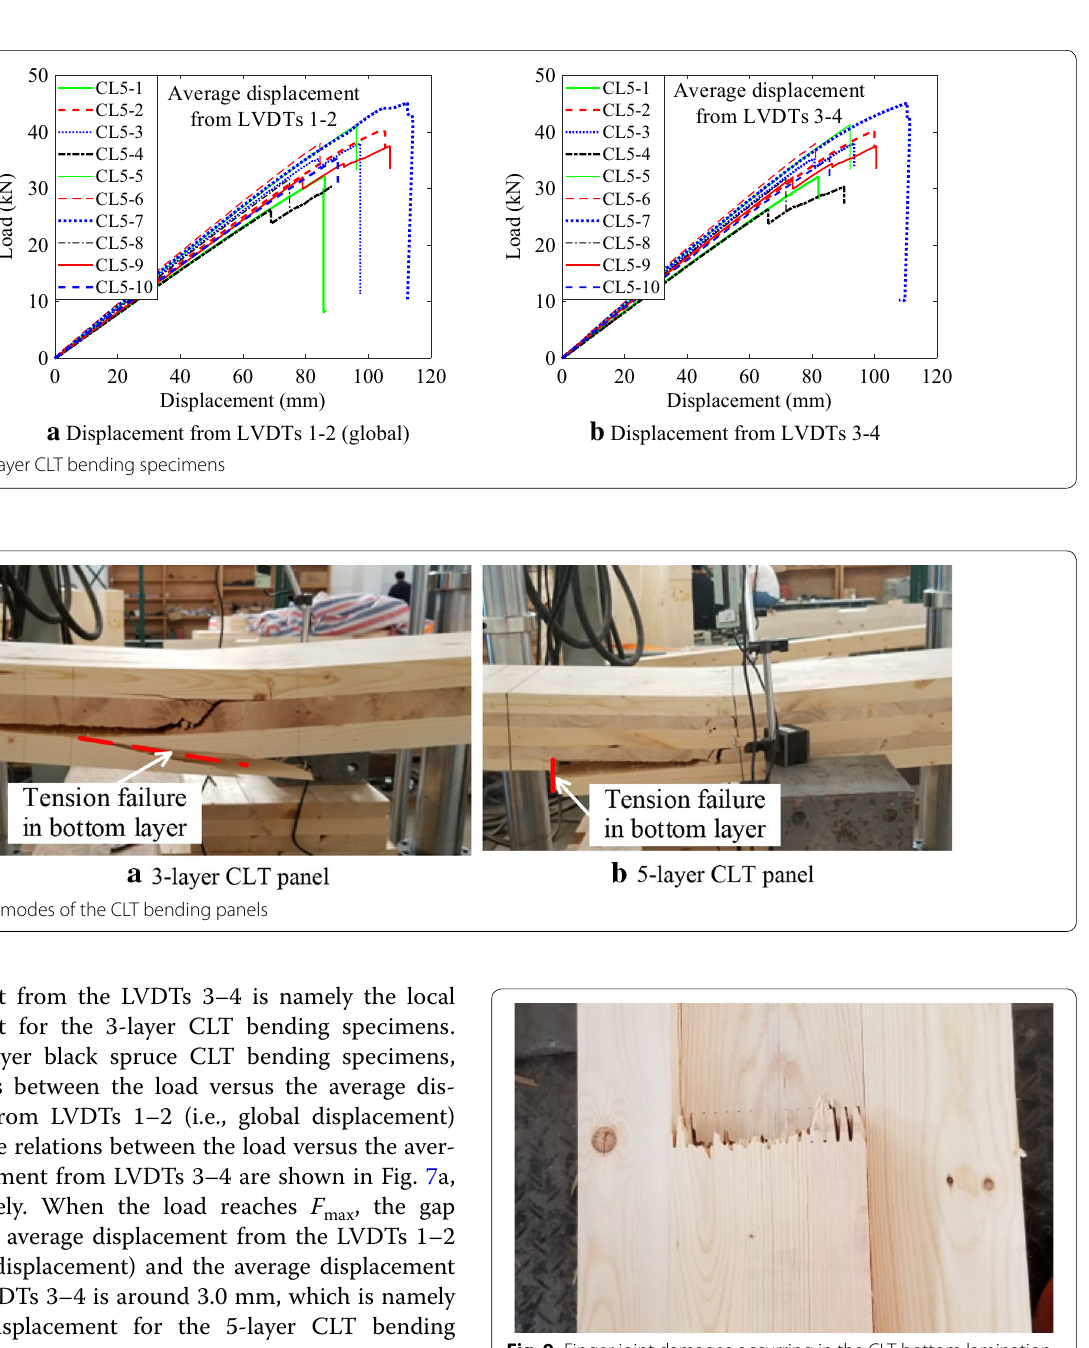
Fig. 9 Finger joint damages occurring in the CLT bottom